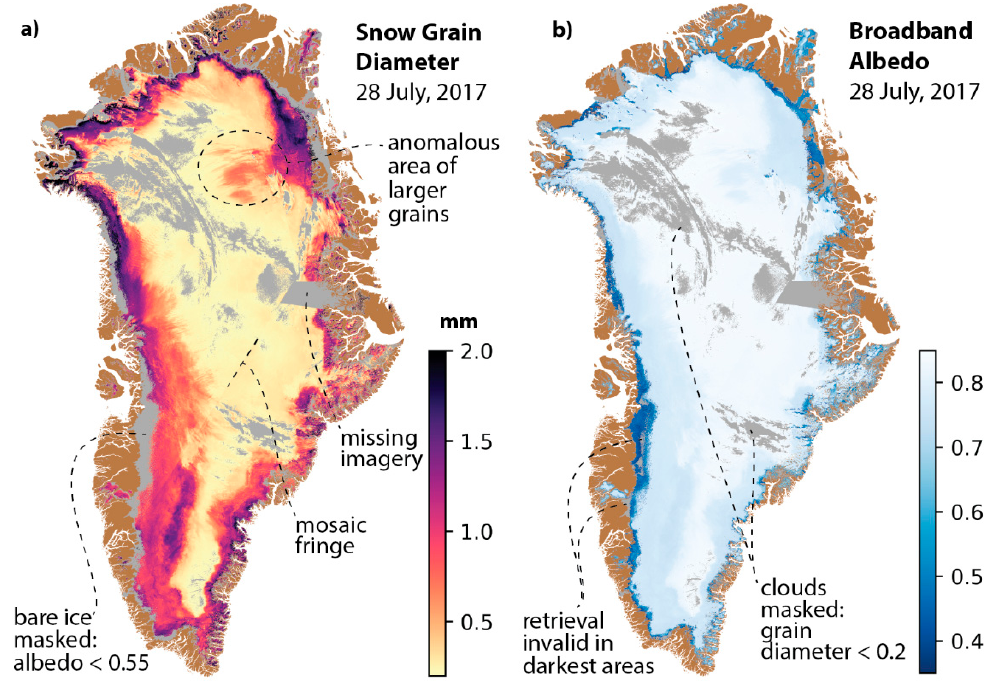
Figure 18. Example Sentinel-3 daily mosaics of ( a ) snow grain diameter for areas classified as snow using broadband albedo above 0.55 and ( b ) OLCI-derived broadband albedo. The chosen date on 28 July 2017 was a date with little cloud cover over the entire ice sheet.